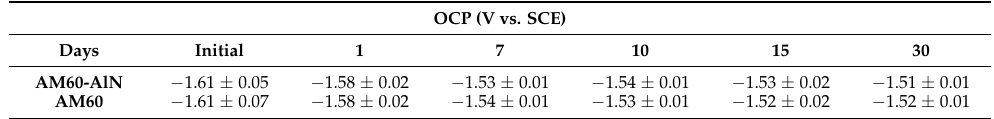
Table 1. Free corrosion potential (OCP) values during the exposure of AM60-AlN and AM60 up to 30 days to a simulated marine environment